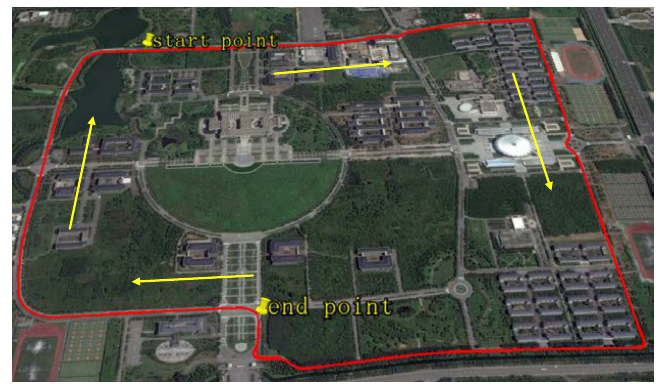
Figure 8. Route of the vehicle.